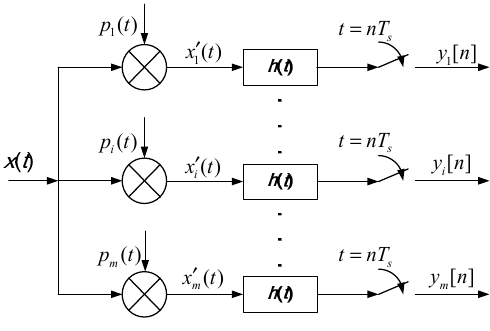
Figure A1. MWC under-sampling system.